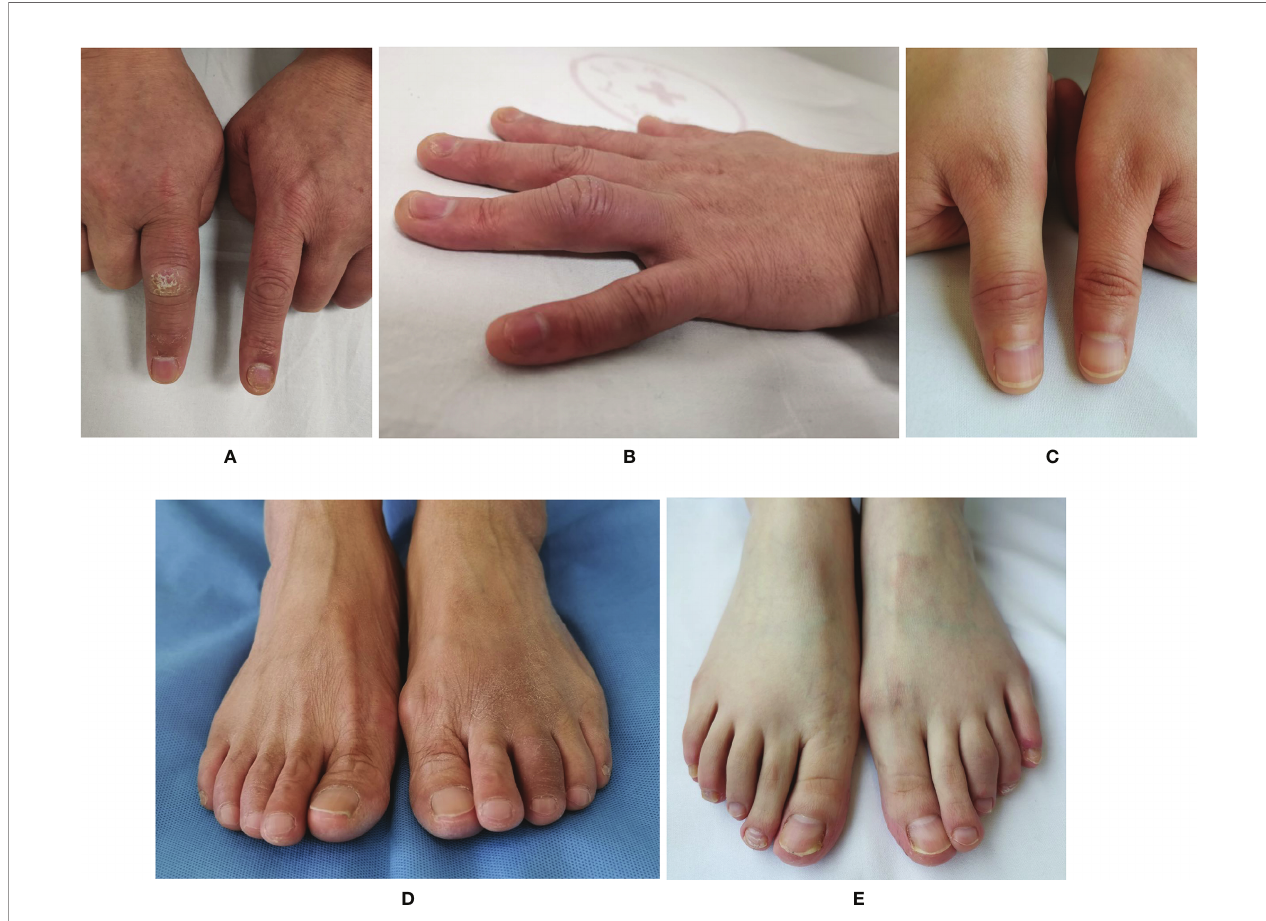
FIGURE 5 | Different manifestations of dactylitis. (A) Typical dactylitis in the index fi nger of right hand. (B) Atypical dactylitis of the ring fi nger with marked swelling of the proximal interphalangeal joints but without metacarpophalangeal and distal interphalangeal joints involved. (C) Atypical dactylitis in the thumb of the right hand with marked swelling of the interphalangeal joint of thumb but without metacarpophalangeal joint involved. (D) Typical dactylitis in the third toe of left foot with whole toe swelling. (E) Atypical dactylitis in the third toe of left foot with marked swelling of the proximal interphalangeal joint of third toe but without metatarsophalangeal and distal interphalangeal joints